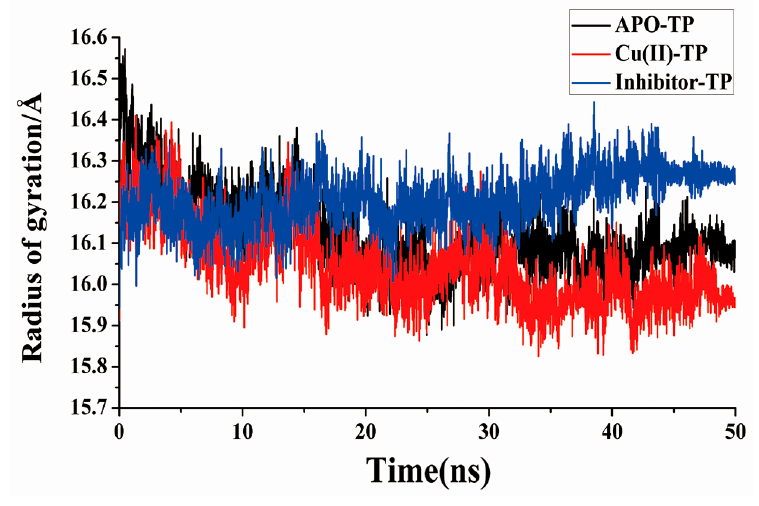
Figure 6. Radius of gyration (Rg) of the APO-TP, Cu(II)-TP and Inhibitor-TP models.